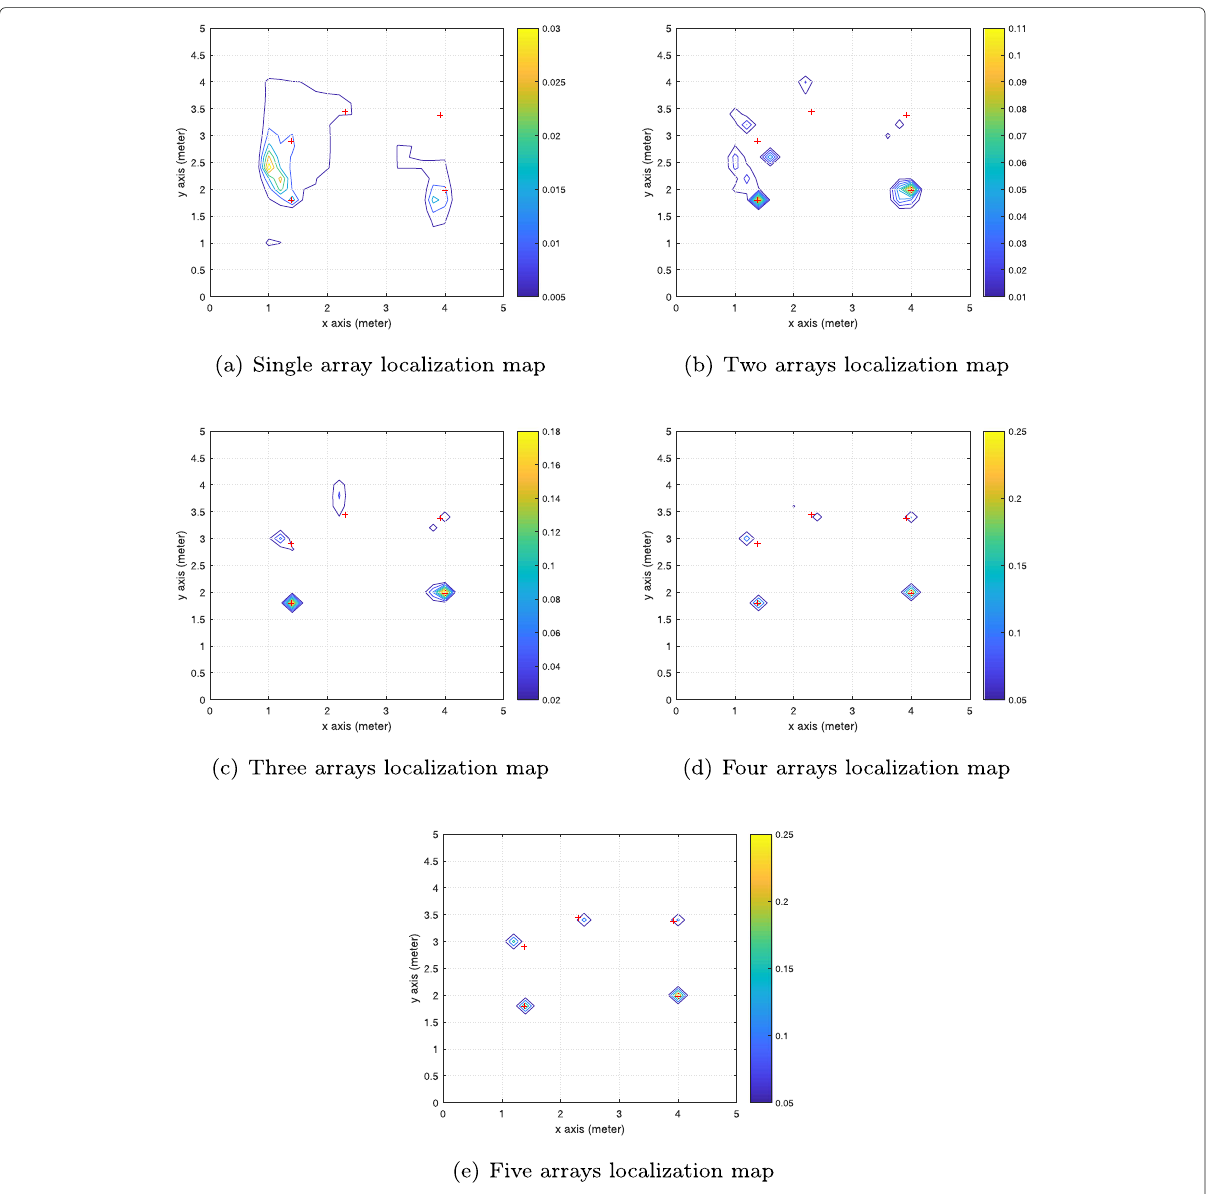
Fig. 4 Localization soft maps intermediate results ( a – e ). The real locations of the simulated speakers are marked by ‘ + ’. The estimation is given by colored contours. The grid resolution is 20 cm. We excluded strips of 100 cm near the walls from the search area